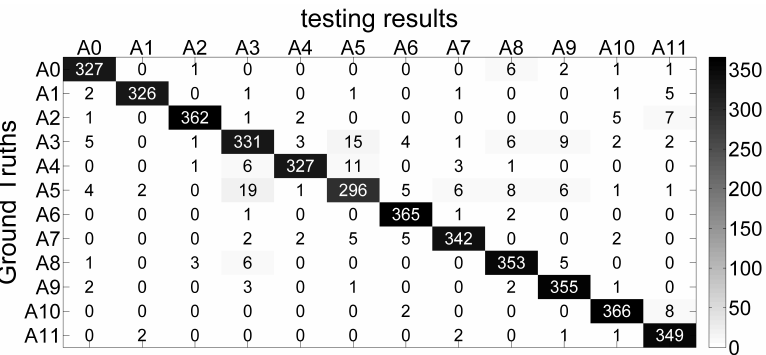
Figure 3. The confusion matrix obtained by applying random